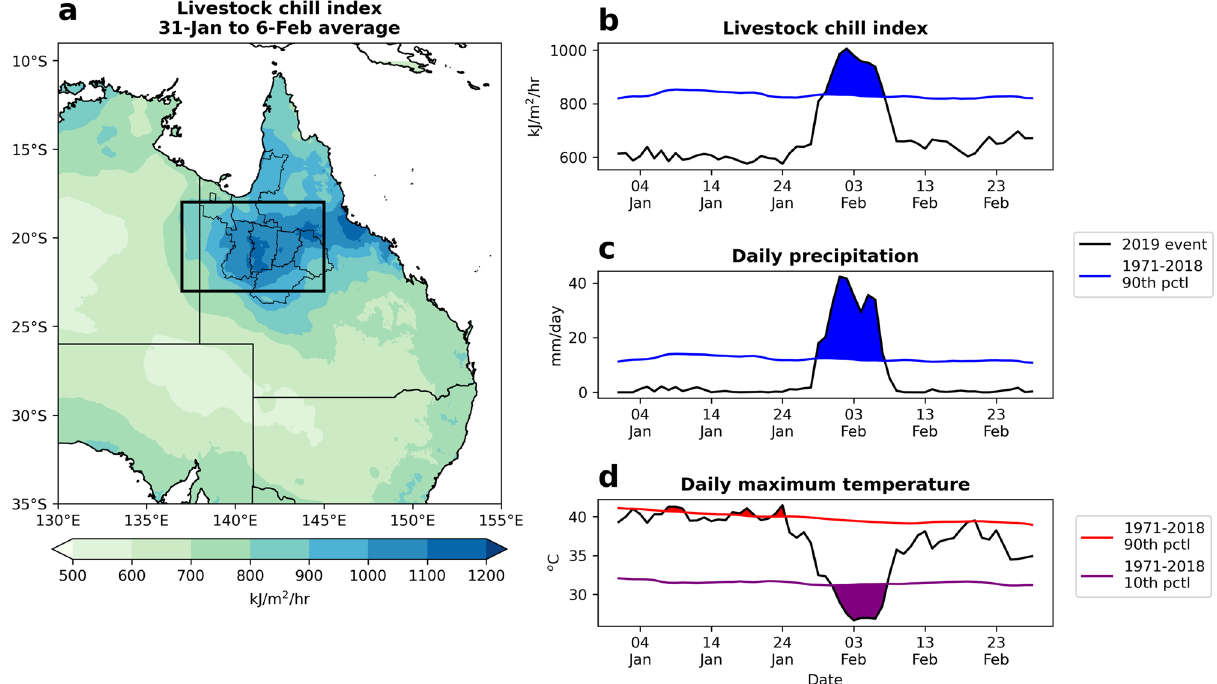
Figure 2. Average livestock chill conditions during the February 2019 floods. ( a ) Spatial pattern of the livestock chill index averaged over 31 January to 6 February 2019. ( b ) Area averaged livestock chill index (black line) over the Gulf region (rectangular region, 137–145° E, 18–23° S) from 1 January to 28 February, with a multi-year daily 90th percentile for 1971–2018 (blue line) and days above the 90th percentile (shading). ( c , d ) As in ( b ) but for ( c ) daily precipitation and ( d ) daily maximum temperature, with the 90th (red line) and 10th (purple line) percentiles. The method for calculating the multi-year daily percentile is detailed in the Data and methods. The Gulf region represents the area with the highest livestock losses during the week-long event (Fig.